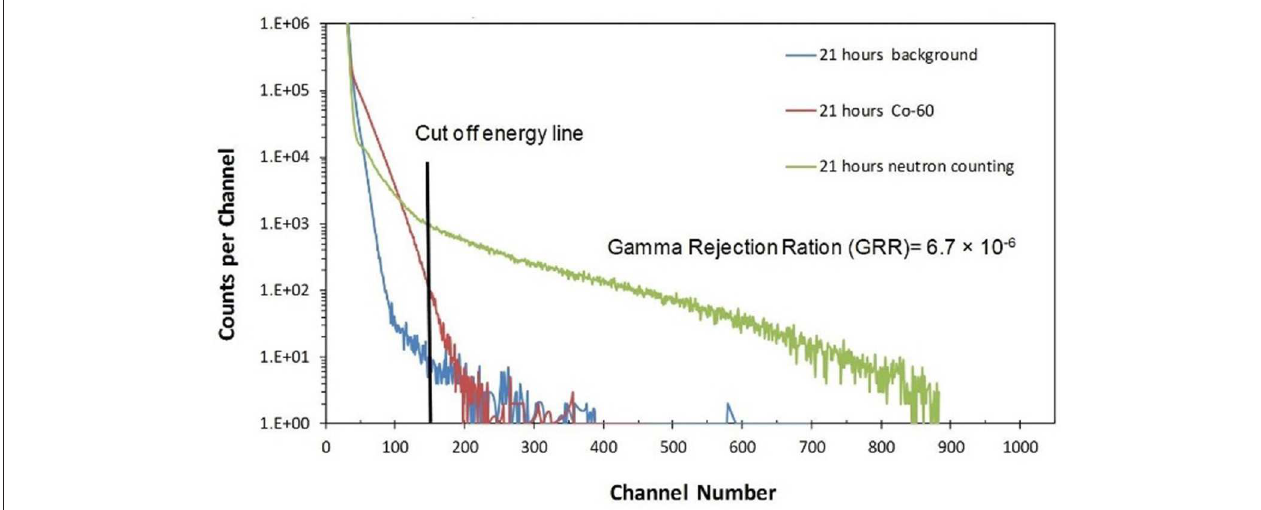
FIGURE 8 | Neutron, gamma-ray, and background spectra of 241 AmBe and 60 Co obtained over a 21-h period under continuous bias using 6 LiInSe 2 -G77-6 sample with Fe contacts. The cut off energy line was chosen to be around channel 150, close to endpoint of 60 Co gamma ray energy line. The GRR was estimated to be around 1.94 × 10 − 6 for 6 LiInSe 2